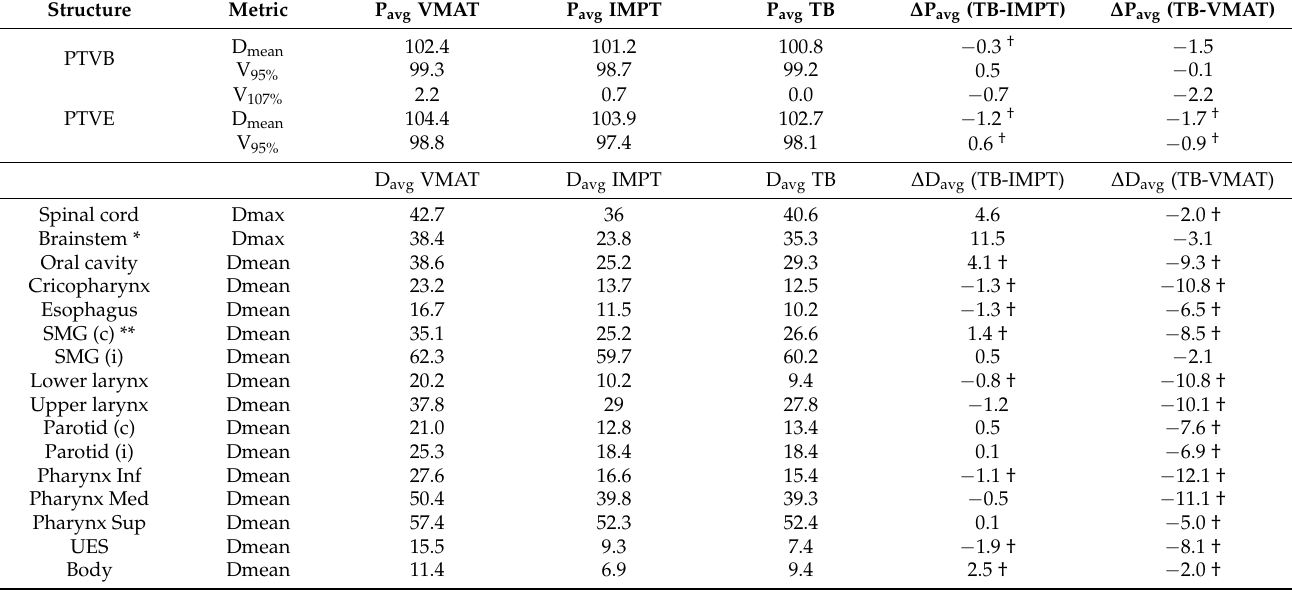
Table 1. Dose statistics volumetric-modulated arc therapy (VMAT), intensity-modulated proton therapy (IMPT) and transmission beams (TB) plans. Average target dose percentages for target structures (Pavg) and average doses (Gy) for organs-at-risk (OARs) (Davg), difference between TB and IMPT/VMAT ( ∆ Pavg / ∆ Davg). SMG = submandibular gland, UES = upper esophageal sphincter, c = contralateral, i = ipsilateral. Structure